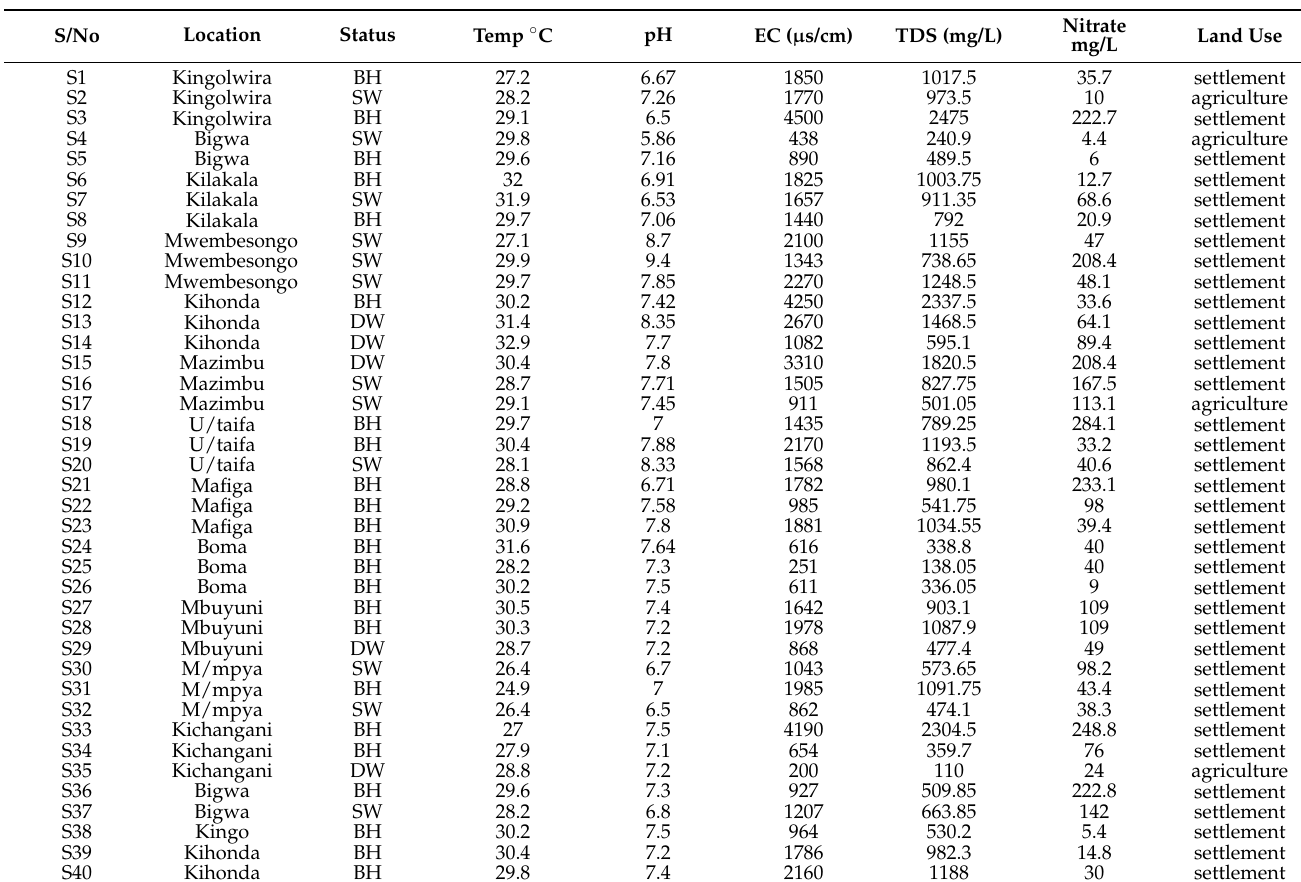
Table 4. Groundwater samples and their physico-chemical parameters and nitrate